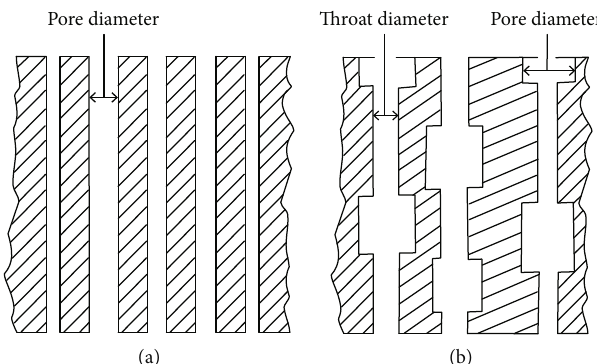
Figure 3: Experimental model diagram (modi fi ed by Puli Chen). (a) Conventional mercury penetration model. (b) Constant-speed mercury penetration model.